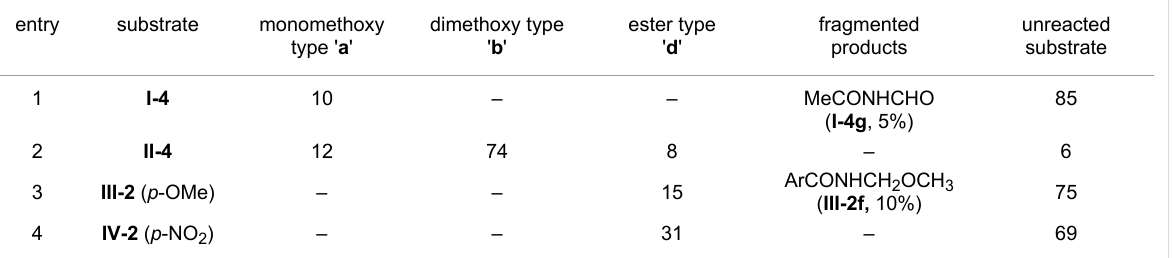
Table 6: Results of anodic oxidation of selected substrates on C felt anode in MeOH/MeCN (1:1)/Et 4 NBF 4 ; 20 mA/cm 2 ; 5 F/mol. entry